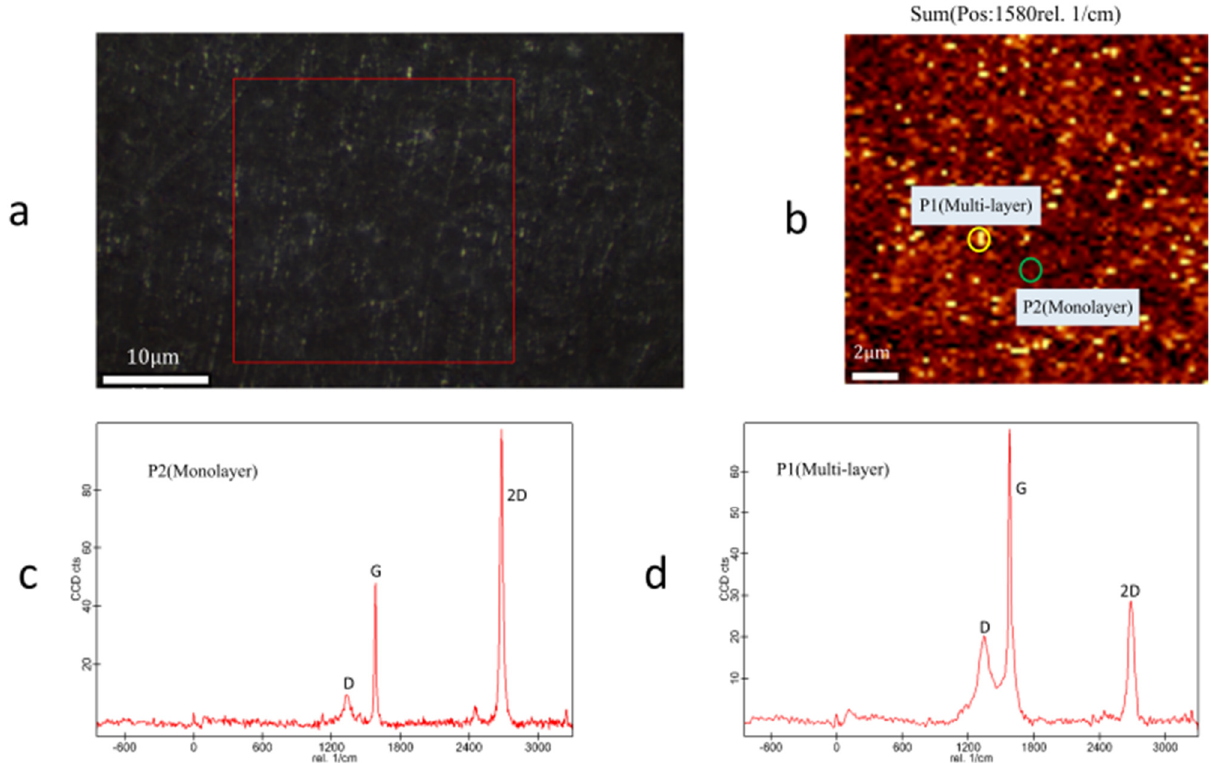
Figure 10. The suspended graphene Raman test. ( a ) Using a 532nm laser to excite the suspended graphene region. ( b ) Raman spectrum in the red frame region generates an image at 1580rel .1/cm. ( c ) Raman spectrum at P2. ( d ) Raman spectrum at P1.